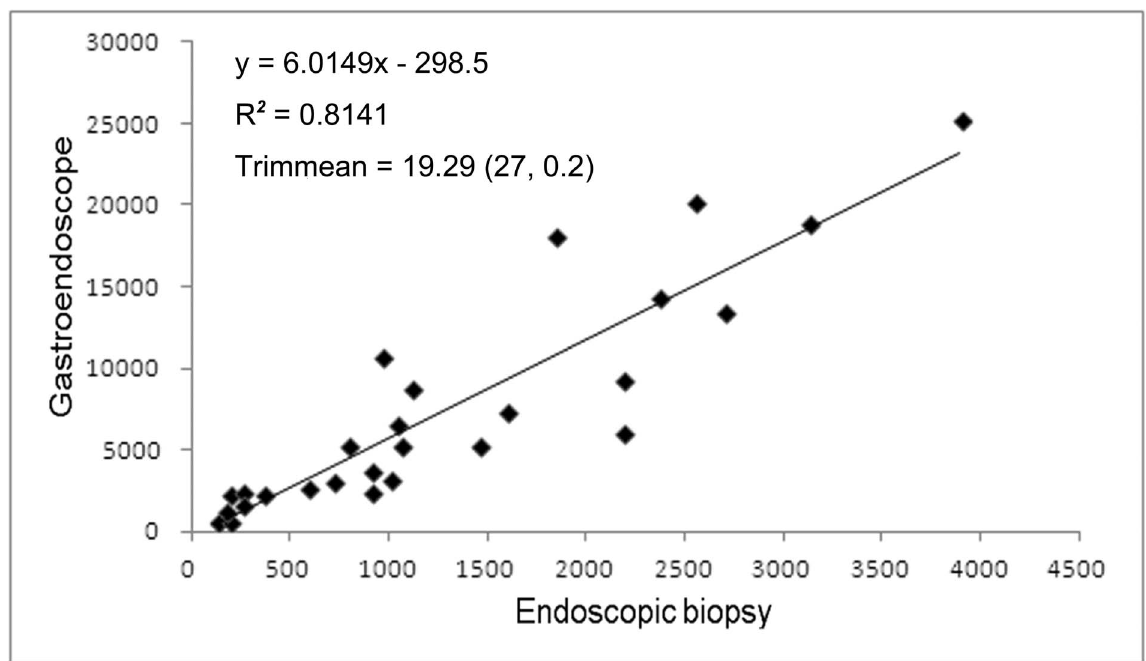
Figure 1. The ratio of the 34,570 endoscopic biopsies and 199,877 gastroendoscopic services with Trimmean (0.2 percent) correction performed by 27 endoscopists including 15 gastroenterologists and 12 hepatologists over 14.5 years.